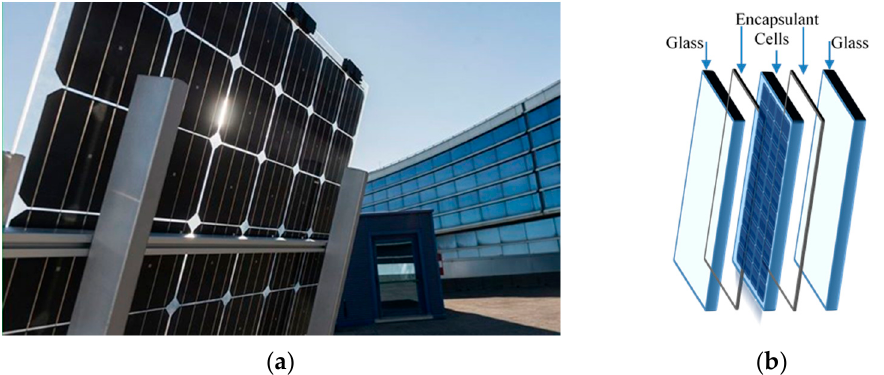
Figure 1. ( a ) New novel high reliable bifacial heterojunction glass/glass PV module and ( b ) its schematic structure (by 3SUN-ENEL Green Power. Catania, Italy).